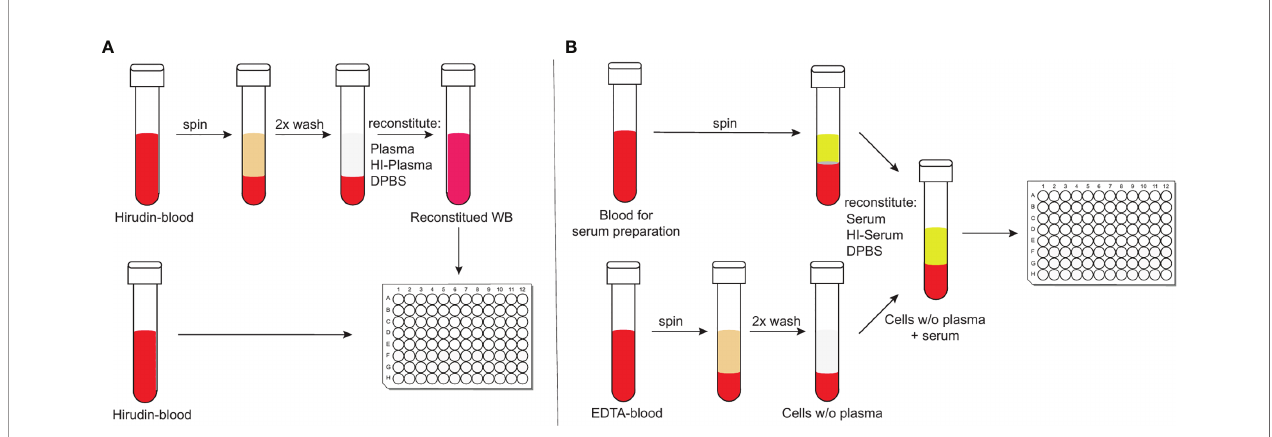
FIGURE 1 | Schematic representation of the two physiological opsonophagocytosis assays. Hirudin-anticoagulated whole blood allows the assessment of bacterial killing in unprocessed whole blood or in reconstituted whole blood with either active or HI-plasma for internal controls (A) . DPBS-washed cells from EDTA- anticoagulated blood can be reconstituted with active serum and represents another physiological opsonophagocytosis assay that can be used to analyze previously stored serum samples (B)